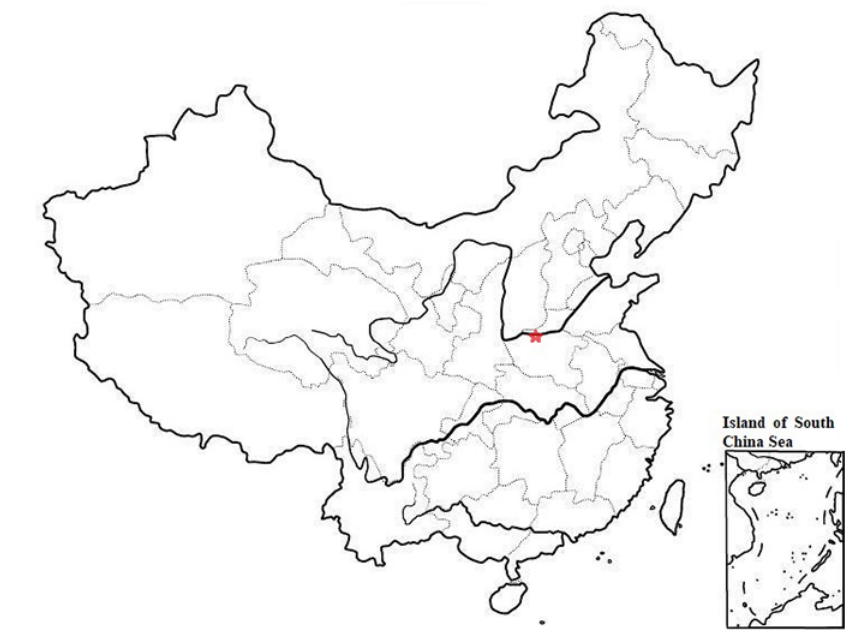
Figure 1 Location of seed sampling sites and experimental sites in